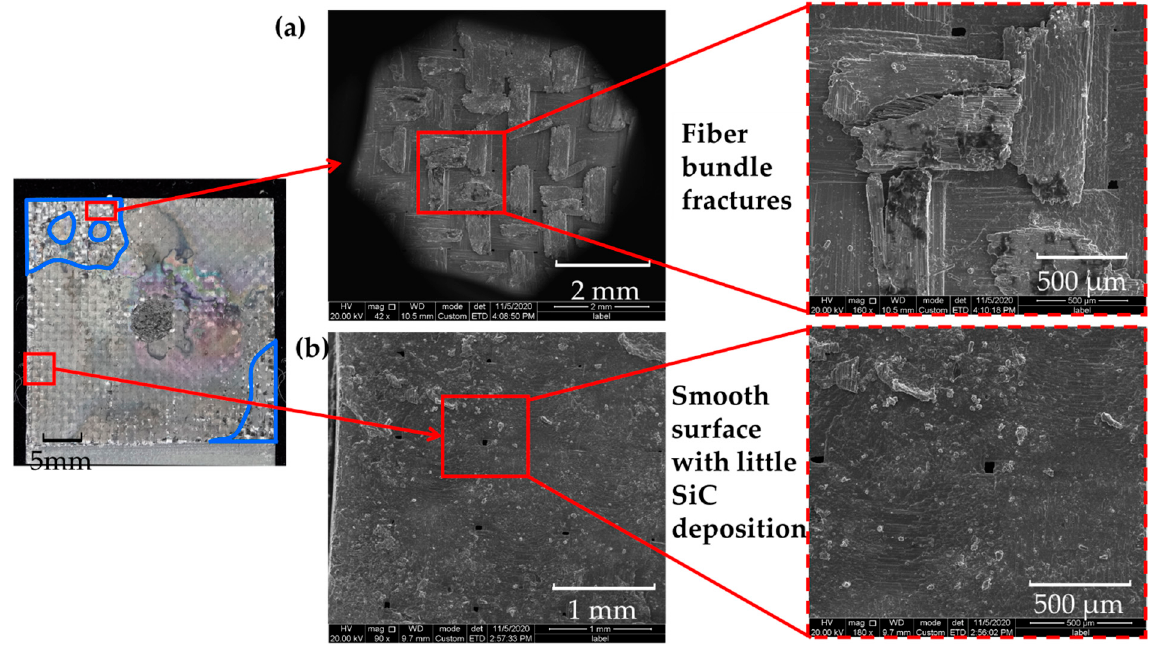
Figure 6. SEM photos of the fracture surface: ( a ) SiC deposition zone; ( b ) smooth surface with little SiC deposition.